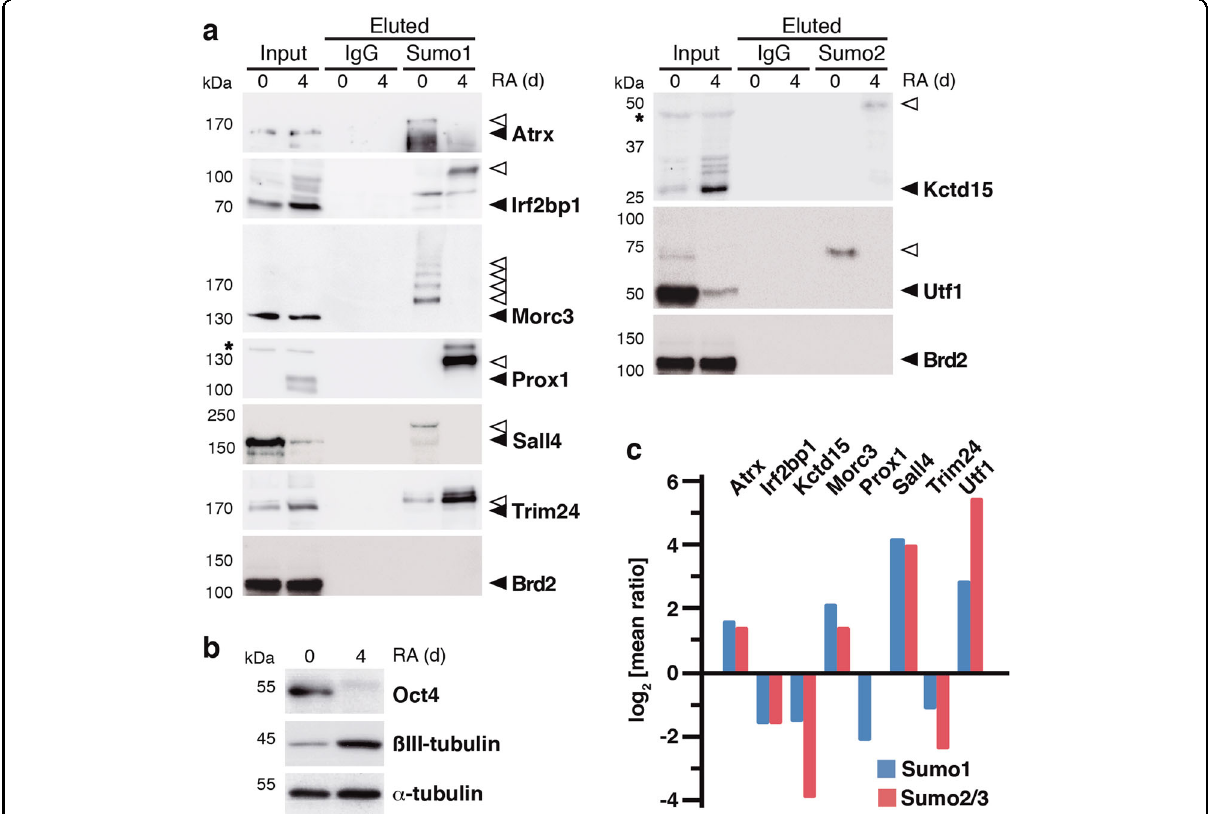
Fig. 2 Selected Sumo targets differentially associated with proliferation and differentiation. a Validation of the proteomic results of a selection of proteins by western blot with speci fi c antibodies against the different proteins, after precipitation with Sumo antibodies or with control IgG and peptide elution (100%), under proliferation (0 days (d)) or differentiation conditions (4 d of RA treatment). Some proteins were validated with Sumo1 antibodies and others with Sumo2/3 antibodies. Inputs (1.5%) are also shown. Black arrowheads indicate unmodi fi ed proteins, while white arrowheads indicate sumoylated products. Asterisks denote nonspeci fi c bands. b Proliferation (0 days) and differentiation conditions (4 days of RA treatment) were checked by analysis of the pluripotency marker Oct4 and the differentiation marker β III-tubulin. α -Tubulin was determined as a loading marker. c The log 2 of the mean value of the ratio in experiment 1 and the inverse ratio in experiment 2 for selected proteins, either for Sumo1 (blue) or for Sumo2/3 (red), is